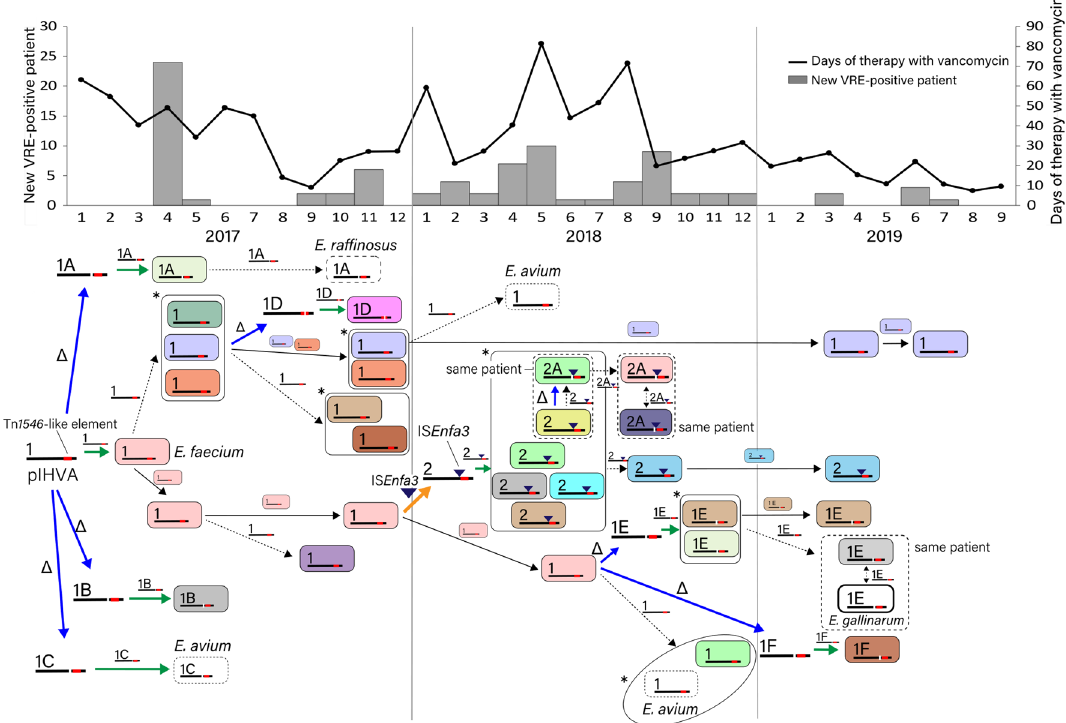
Figure 7. Transmission dynamics of a linear plasmid carrying vanA (pIHVA), monthly new vancomycin- resistant enterococci (VRE) patients, and days of therapy (DOT) with vancomycin in ward A. Time course in the dynamics corresponds to that of the graph. The color of the isolate indicates the pulsotype of PFGE as shown in Fig. 2. The number on the linear plasmids represents the type of pIHVA. Epidemiological investigation, transmission of strains and plasmid transfer between strains. Vancomycin use was high in ward A during the period when diverse VREs were detected. Arrows: black, clonal spread; black dot, transmission of pIHVA;